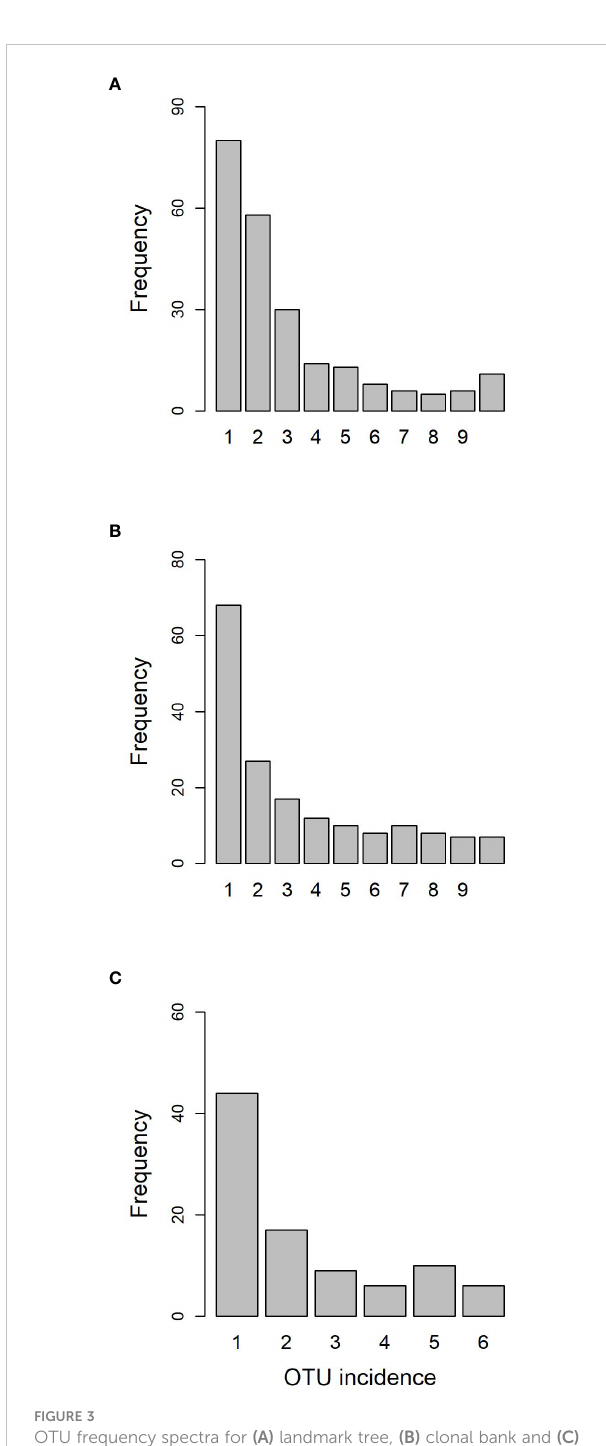
FIGURE 3 OTU frequency spectra for (A) landmark tree, (B) clonal bank and (C) Rivas